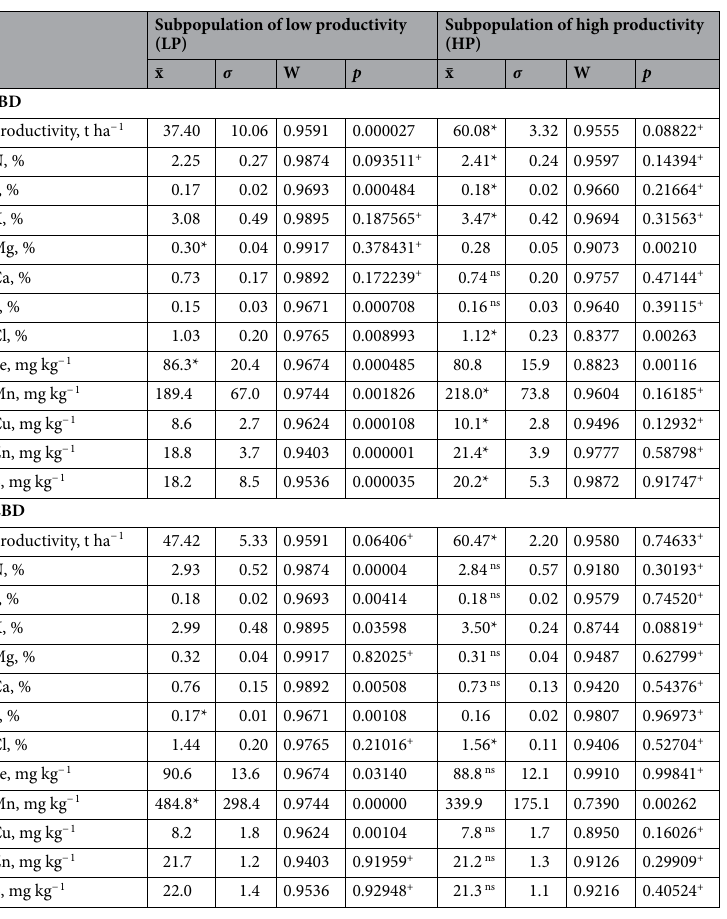
Table 1. Means, standard deviation and Shapiro–Wilk normality test of productivity and concentration of nutrients for low and high productivity subpopulations obtained in the database aiming to determine the initial and field experiment data for DRIS norms. + denotes a normal population distribution. *means between the LP and HP subpopulations are significantly different at ≤ 0.05 using the F test for variances of two samples. IBD initial data base for DRIS norms, EBD experiment data base for DRIS norms